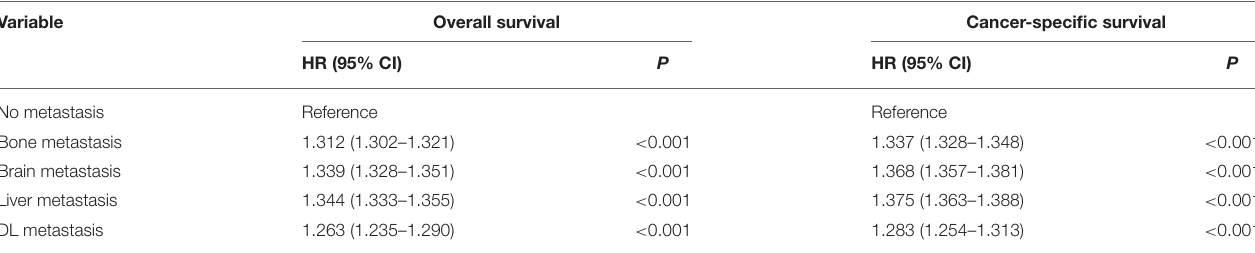
Adjusted for histological type, gender, age, race, marital status, grade, tumor size, regional lymph node invasion and therapies. OS, Overall Survival; CSS, Cancer Specific Survival; HR, Hazard Ratio.